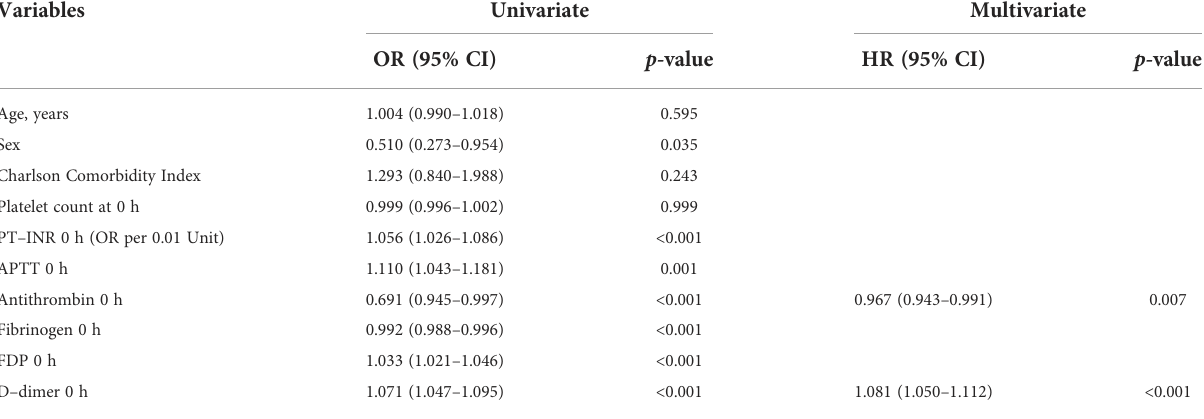
TABLE 2 Logistic regression analysis of variables that predict DIC onset during the 24 h after